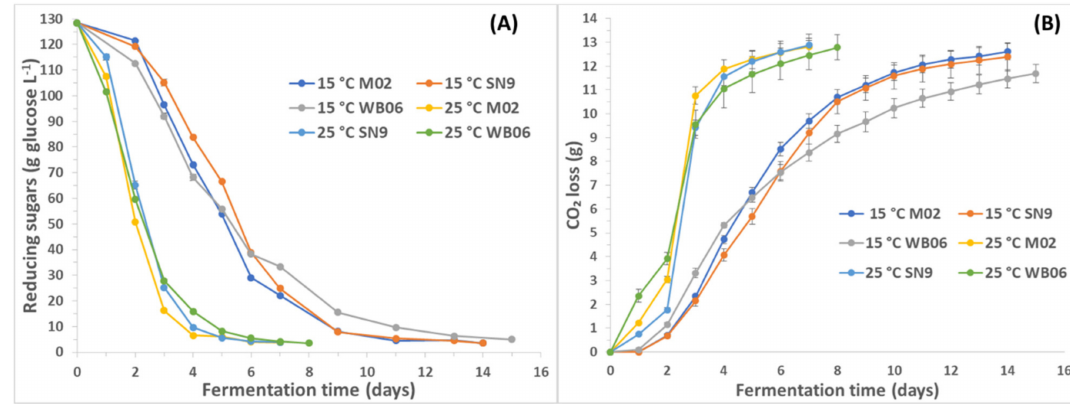
Figure 1. E ff ect of yeast strain and temperature on fermentation kinetics (reducing sugars ( A ) and CO 2 loss ( B )) of